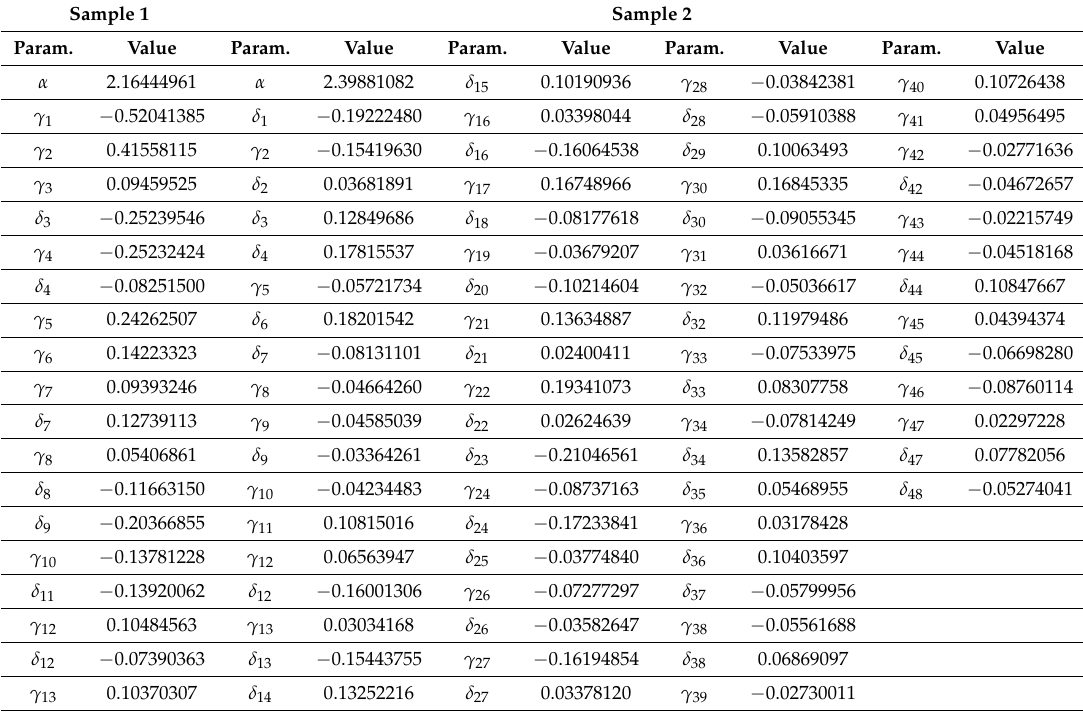
Table A3. Estimated parameter (Param.) of H s series.